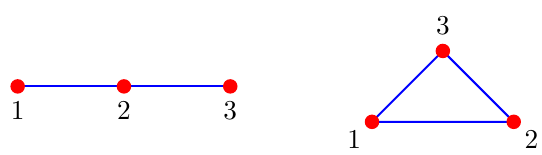
models (right). The heights are labelled by Figure 4 . Adjacency graphs of the A 3 (left) and A (1) 2 1, 2, 3. The graph of A leads to the Ising model, as the | a − b | = 1 rule means that the lattice 3 contains a fixed (“frozen”) sublattice consisting of only the height 2, leaving only heights 1 and 3 as dynamical variables (the “up” and “down” spins). The A (1) diagram forms the basis for the 2 adjacency graphs which are relevant to the dilute vertex models we are interested in. figure 4 for examples of RSOS and CSOS adjacency graphs for the simple case where there are only three